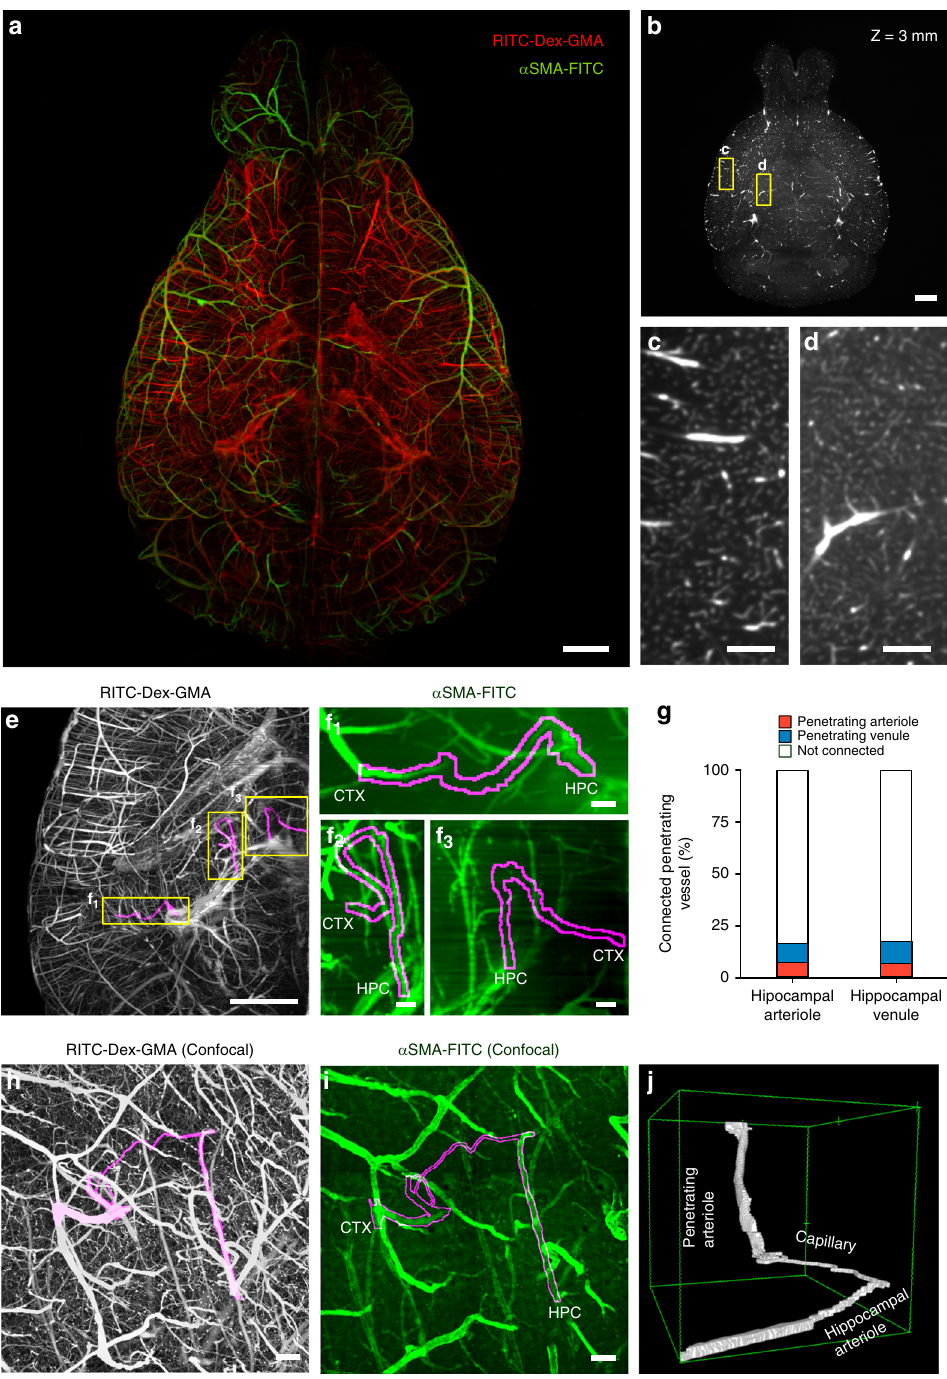
Fig. 5 Large-scale molecular phenotyping-compatible 3D imaging of cerebral vasculature. a Maximum projection of light-sheet fl uorescence microscopic images of the entire vasculature in a SeeNet-treated brain (1.6× zoom, ×0.63 objective lens, numerical aperture: 0.15, working distance: 87 mm) into a single stacked photo. Casted vessels are shown in red. Arterioles immunolabeled with anti- α SMA are shown in green. Scale bar = 1 mm. b The RITC – Dex – GMA signal in a , shown on a grayscale, was optically sectioned at Z = 3 mm. Scale bar = 1 mm. c, d Magni fi ed images of the boxed region of b . Vasculature in the gray matter c and white matter d was visualized with capillary resolution. Scale bar = 200 μ m. e The RITC – Dex – GMA signal in a posterior part of the left hemisphere in a is shown on a grayscale. Magenta indicates cortico-hippocampal vascular paths observed in this area. Scale bar = 1 mm. See also Supplementary Movie 3. f The anti- α SMA immunosignal of the boxed regions in e is shown on a green scale. Magenta contours indicate cortico-hippocampal vascular paths. Each end of the vascular path is denoted by CTX (cortical side) or HPC (hippocampal side). Arteriole – arteriole (f 1 ), venule – arteriole (f 2 ), and venule – venule (f 3 ) connections were observed. Scale bar = 100 μ m. See also Supplementary Movie 4. g The percentage of the connected pairs of dorsal hippocampal transverse arterioles (red) and venules (blue) to the total number of vessels observed. h Maximum projection of confocal images of casted vasculatures from the pia to the hippocampus. A cortico-hippocampal vascular path is shown in magenta. Scale bar = 100 μ m. See also Supplementary Movie 5. i The anti- α SMA immunosignal in the same fi eld is shown on a green scale. Scale bar = 100 μ m. See also Supplementary Movie 6. j A 3D-rendered view of the cortico-hippocampal vascular path. Source data are provided as a Source Data fi